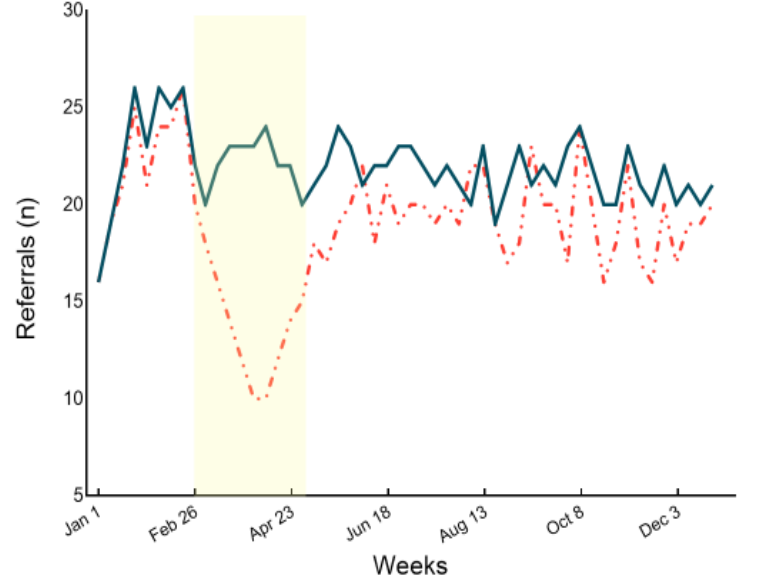
Figure 2. Weekly volume of referrals in 2019 and 2020. The shaded area depicts the COVID-im-